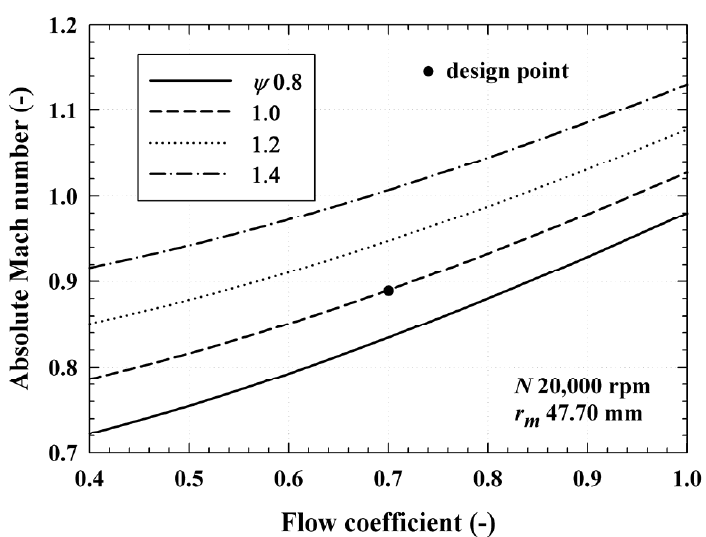
Figure 7. Absolute Mach number ( Ma ) at the turbine stator outlet when the flow coefficient ( ϕ ) ranges from 0.4 to 1.0 and loading coefficient ( ψ ) ranges from 0.8 to 1.4.